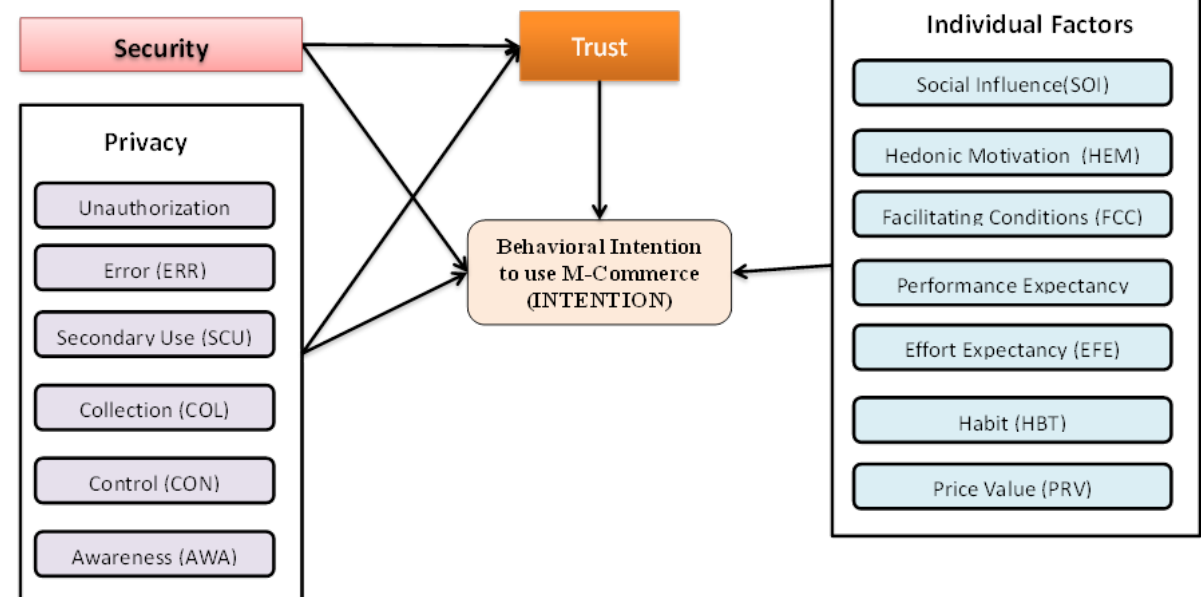
Figure 1. Proposed